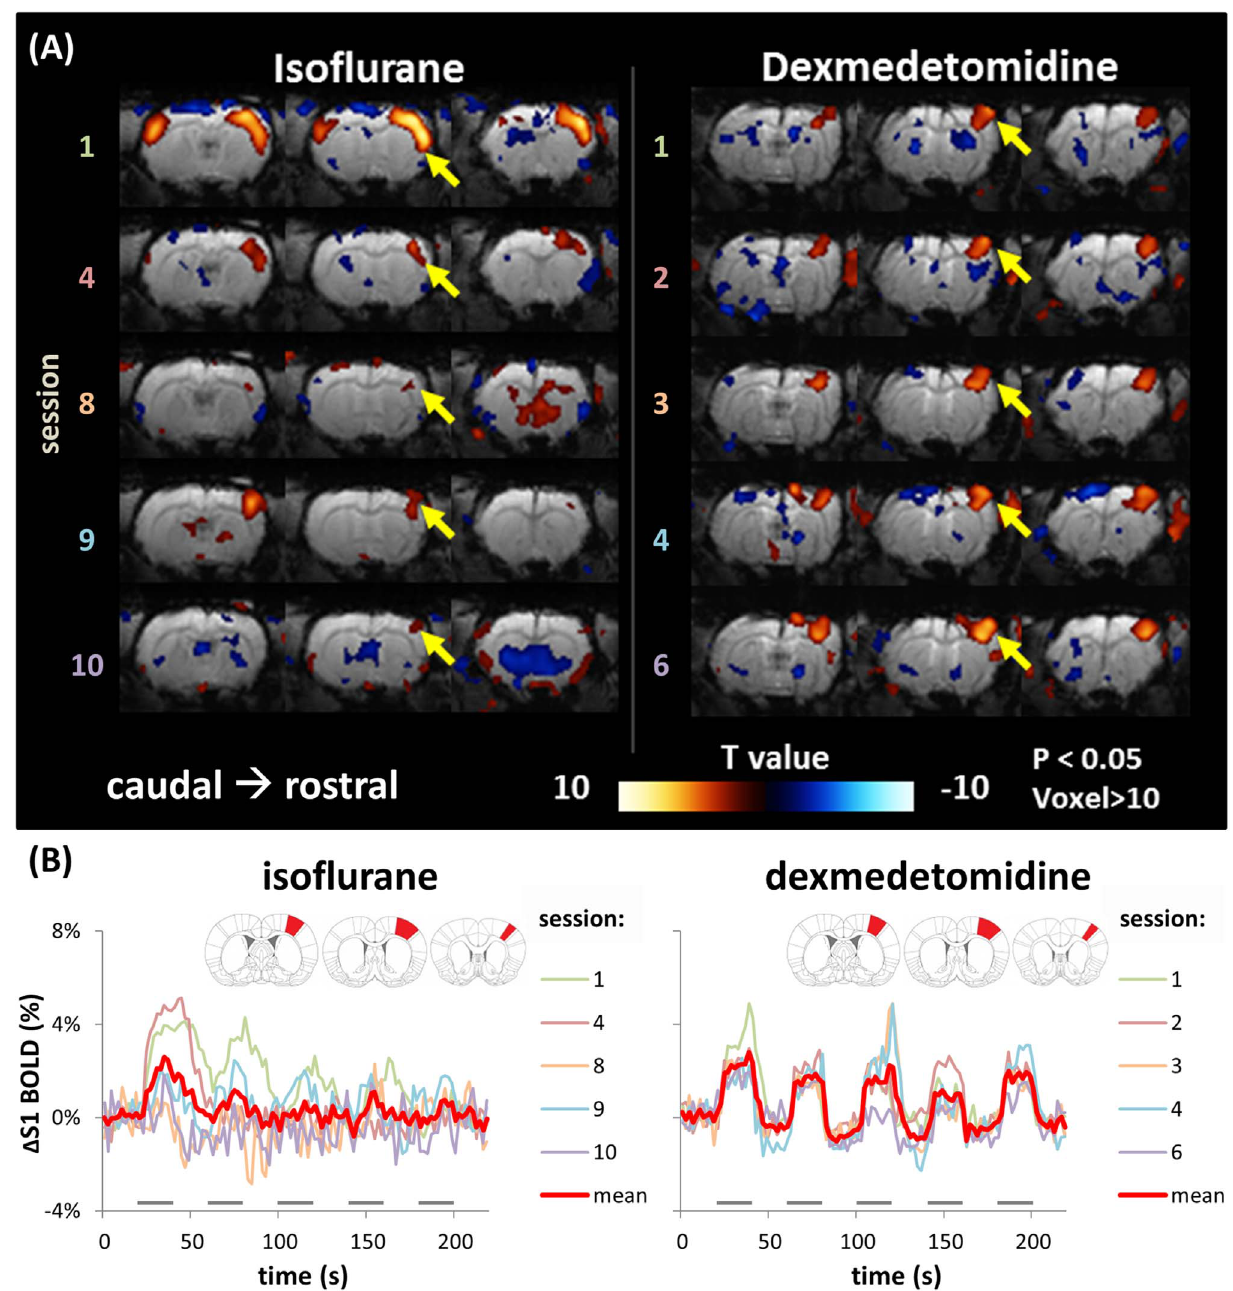
Figure 5. Stability of DBS-induced BOLD response under isoflurane and dexmedetomidine anesthesia among a series of sessions within a one-day experiment. Here shows the examples from one animal under isoflurane- and dexmedetomidine-based fMRI, tested on different days respectively. (A) The BOLD activation maps ( P , .05 , voxels . 10) from a consequent of 5 repeated fMRI sessions (inter-scan interval: 10 min) with the same DBS parameter (0.4 ms, 200 m A, 9 Hz). When under dexmedetomidine anesthesia, a stable activation pattern was evident in S1 among sessions. Session 5 was eliminated because of an unexpected animal motion. When under isoflurane anesthesia, although a conserved positive BOLD response was observed in S1, the response pattern varied among sessions. In sessions 2, 3, and 5–7, different stimulation parameters were used, hence they are not shown in this figure. (B) The time courses within S1 for the 5 repeated scans were plotted together. The red trace is the average time course of all 5 scans, and the gray bars under the time courses indicate the 20-s stimulation period. Inset shows the S1-forelimb ROI used to obtain the signal time course. Variability was high under isoflurane anesthesia, compared with that under dexmedetomidine anesthesia.